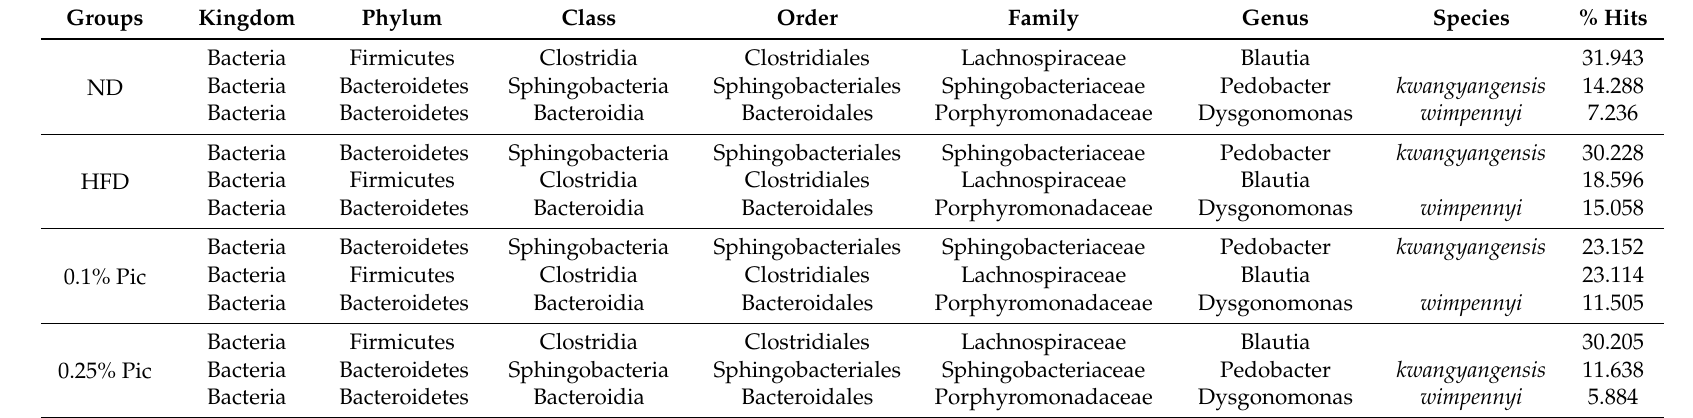
Table 3. The most abundant genera and species of gut microbiota in HFD-fed C57BL/6